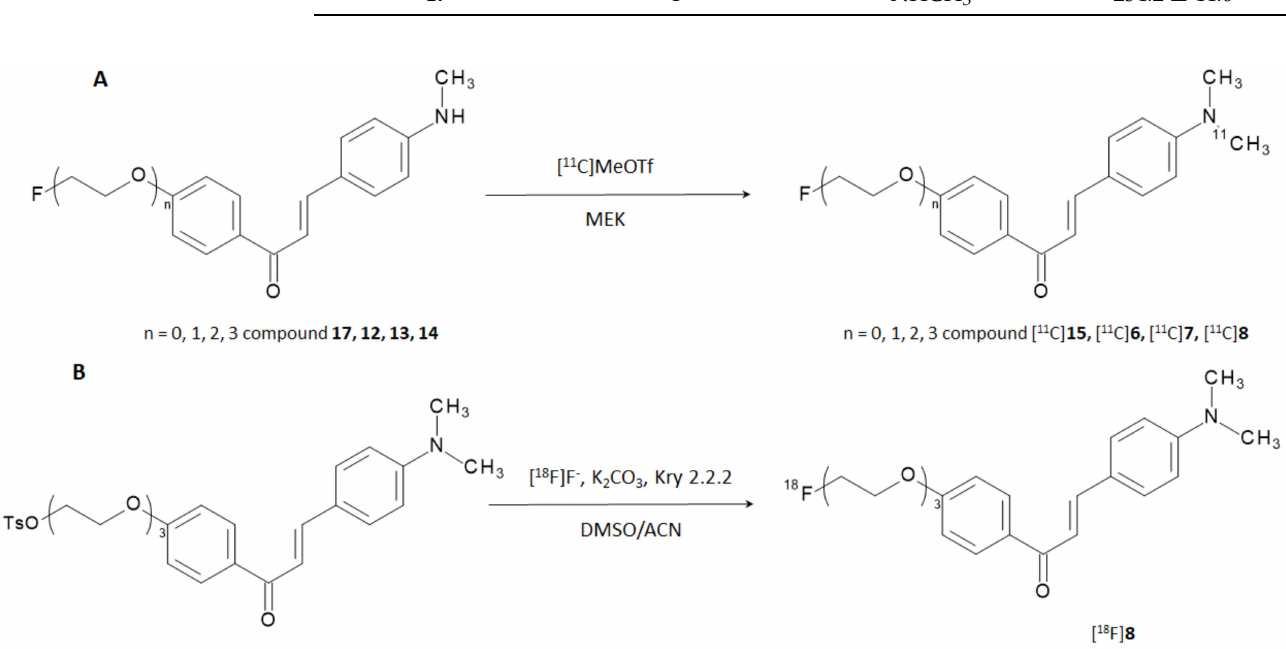
Figure 5. [ 11 C]-labeling ( A ) and [ 18 F]-labeling ( B ) reaction pathways for the preparation of radiotrac- ers based on F- and FPEG-chalcones